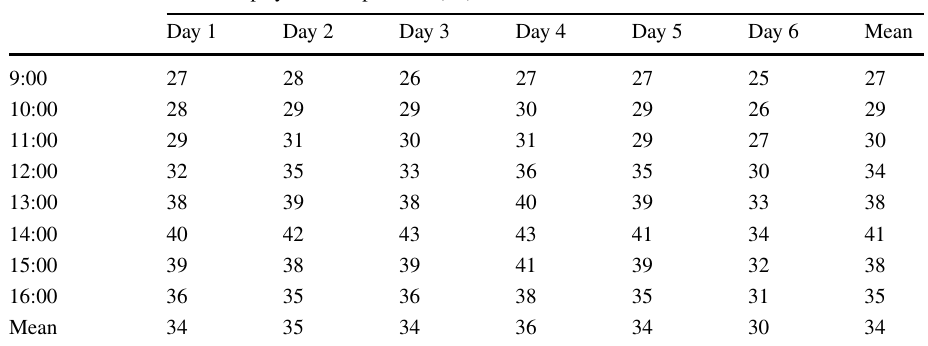
Table 3 Variation in daily hourly ambient temperature during the